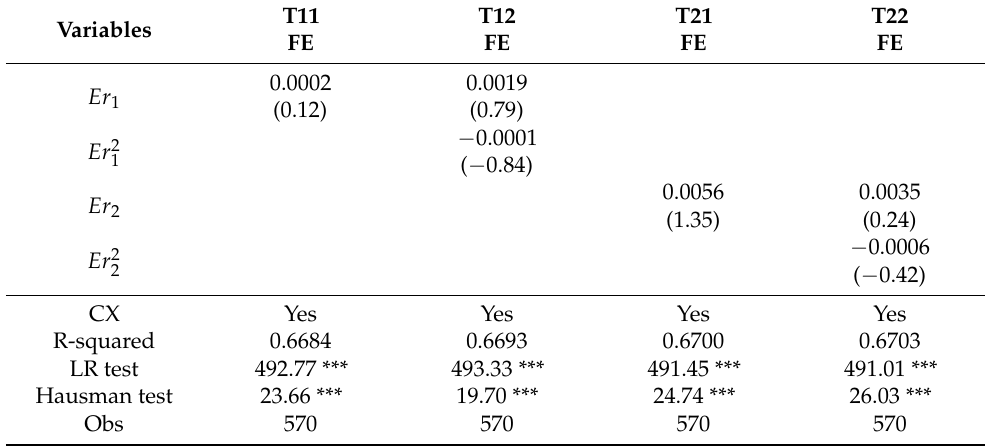
Table 4. Linear and quadratic regressions of command environmental regulations: Nationwide. Variables